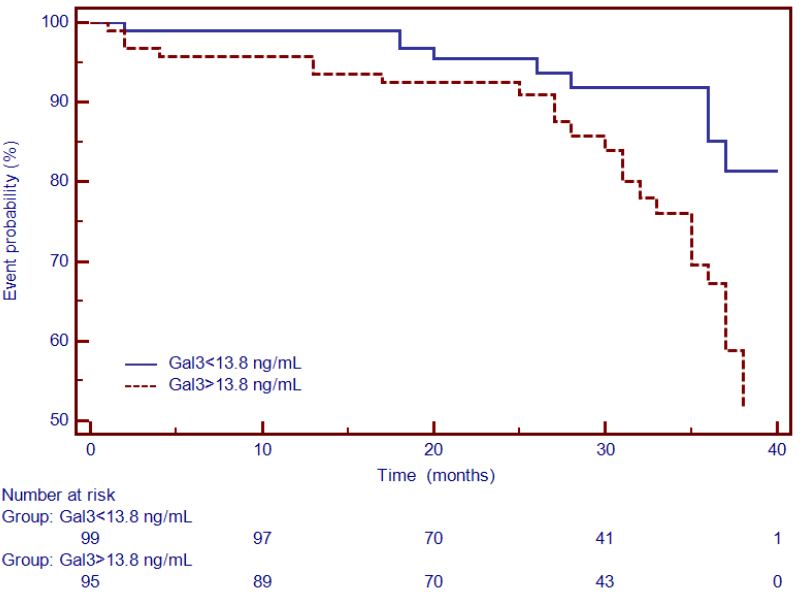
Figure 4. Kaplan – Meier analysis for the ability of Gal-3 to predict cardiovascular outcome. Abbreviations: Gal-3, galectin-3.